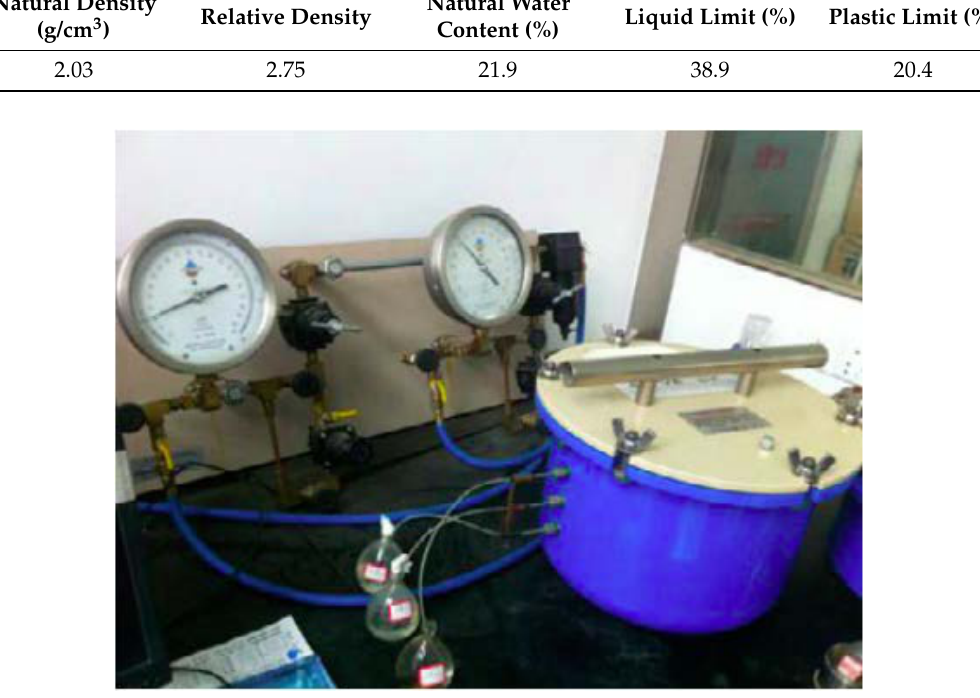
Figure 2. Pressure plate apparatus instrument.